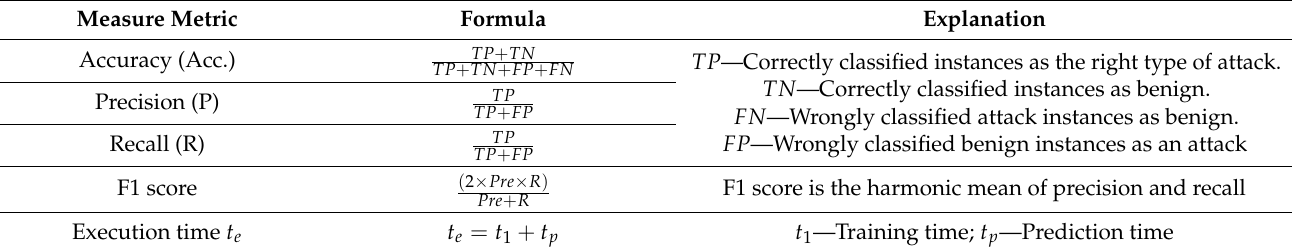
Table 5. Evaluation metrics.